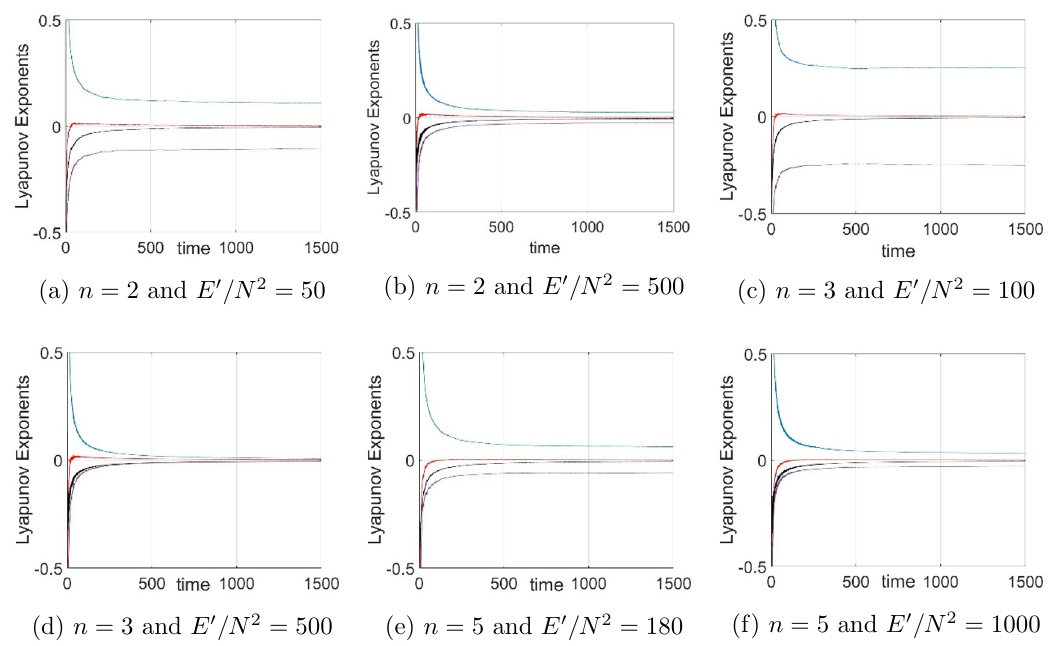
Figure 5. Times series for Lyapunov